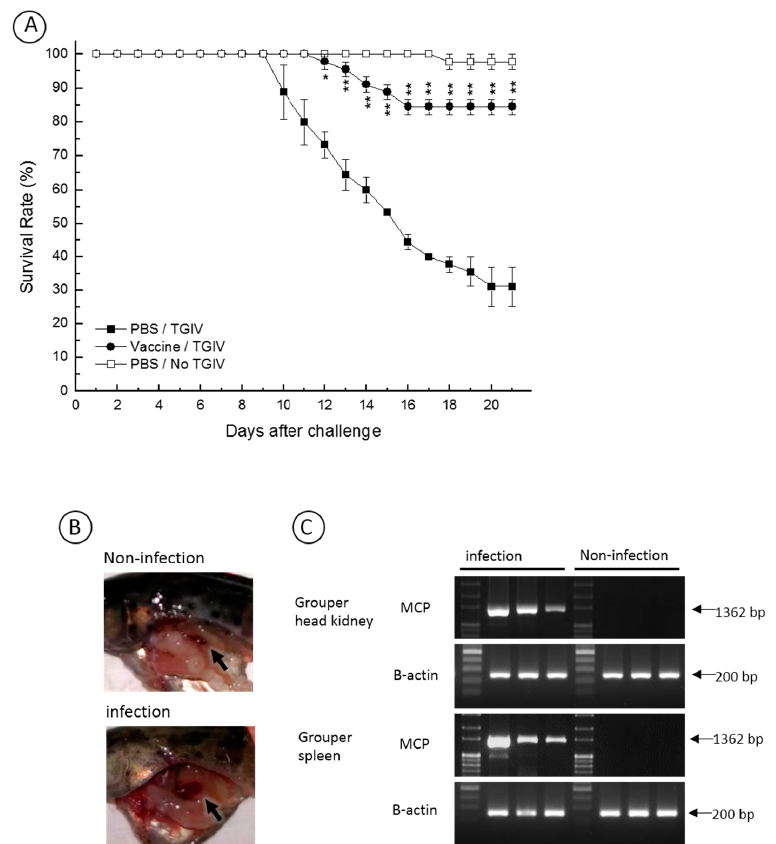
Figure 5. Survival rate of vaccinated and non-vaccinated grouper at different times after challenge with TGIV. ( A ) To test the vaccine efficacy, three treatments were analyzed: (1) vaccination via intraperitoneal injection of recombinant MCP protein, followed by TGIV infection; (2) mock-vaccination via intraperitoneal injection of PBS, followed by TGIV infection; and (3) mock-immunization with PBS only. All groups were carried out in triplicates of 15 fish. The figure shows the average survival rate of the three different groups. The vaccine apparently enhanced the survival rate against TGIV infection with a RPS of about 86% on day 21 post-infection; ( B ) An autopsy was performed on the TGIV-infected and non-infected fish of the mock-vaccinated treatment. Enlargement of spleen, a clinical sign of TGIV infection, was observed in the infected fish but was absent in the non-infected fish. Arrows indicate the spleens; ( C ) The evidence of TGIV replication in the infected fish was assayed. The MCP transcript was detected by RT-PCR in the head kidney and spleen of the infected fish but absent in the non-infected control. * p < 0.05–0.01, ** p < 0.01.